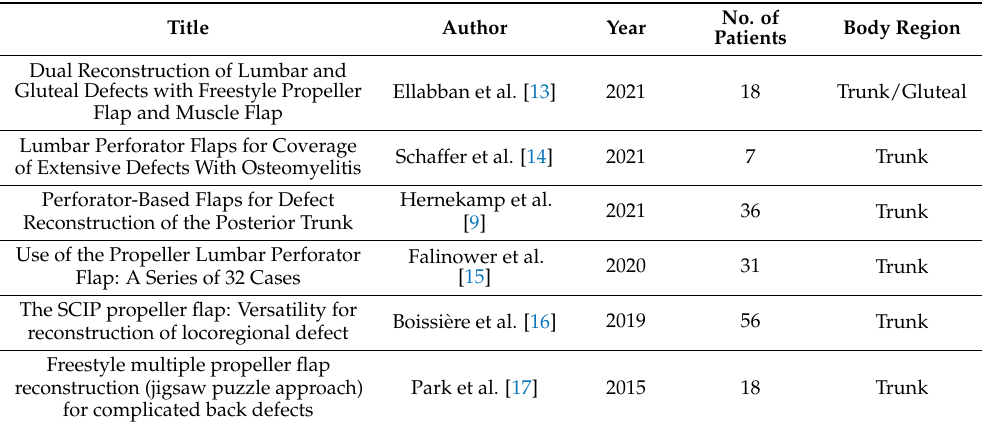
Table 1. Articles 1 reporting the use of combined perforator propeller